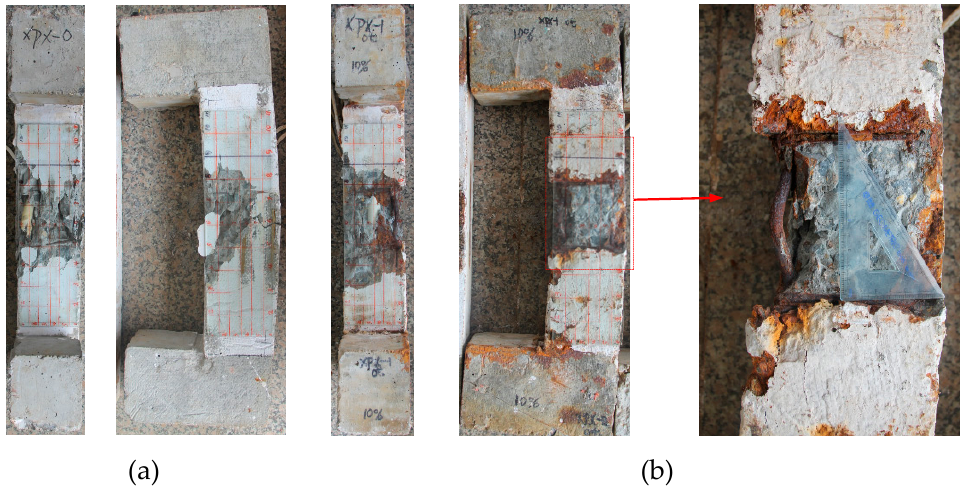
Figure 13. Visual observation of failure characteristics at the surface of RC columns: ( a ) non- corroded column, and ( b ) corroded column.